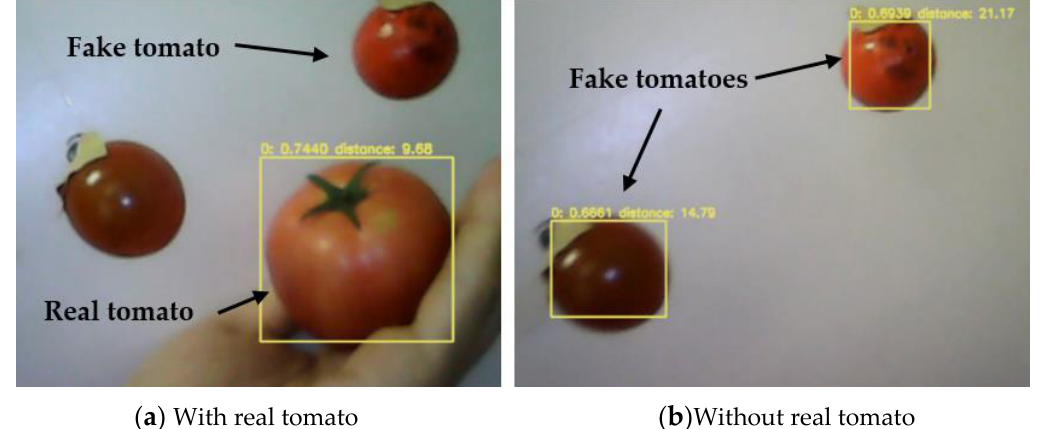
Figure 12. Experiment test with real and fake tomatoes recognition.